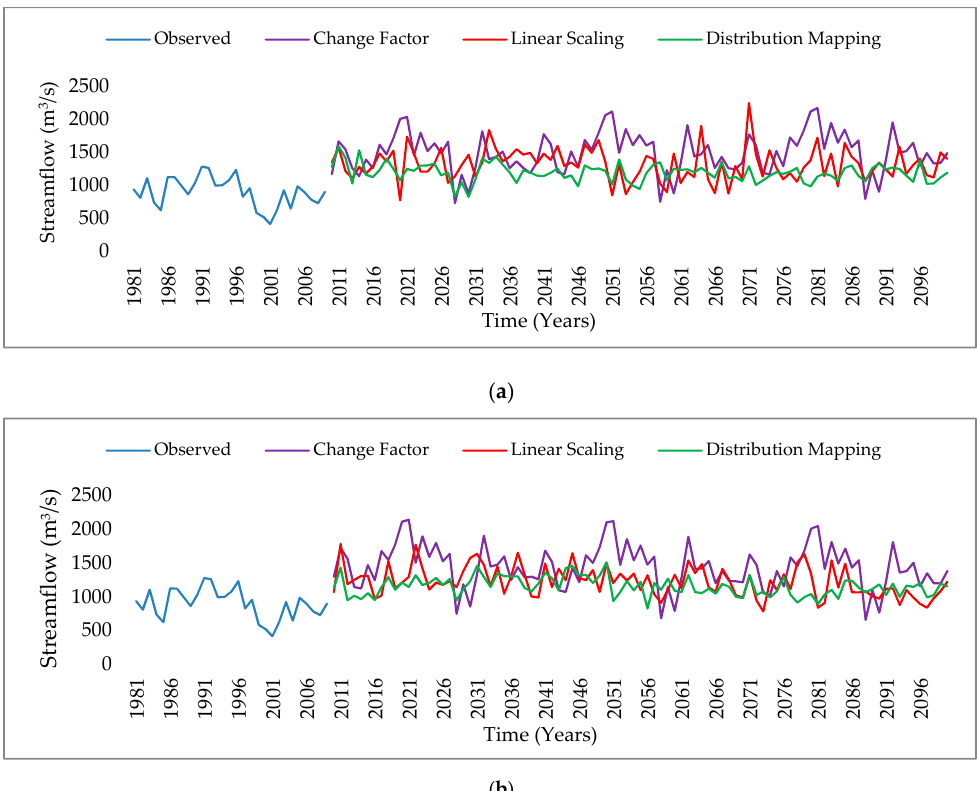
Figure 13. Comparison of GCMs ensemble results under different downscaling techniques and emission scenarios; ( a ) RCP 4.5, ( b ) RCP 8.5.